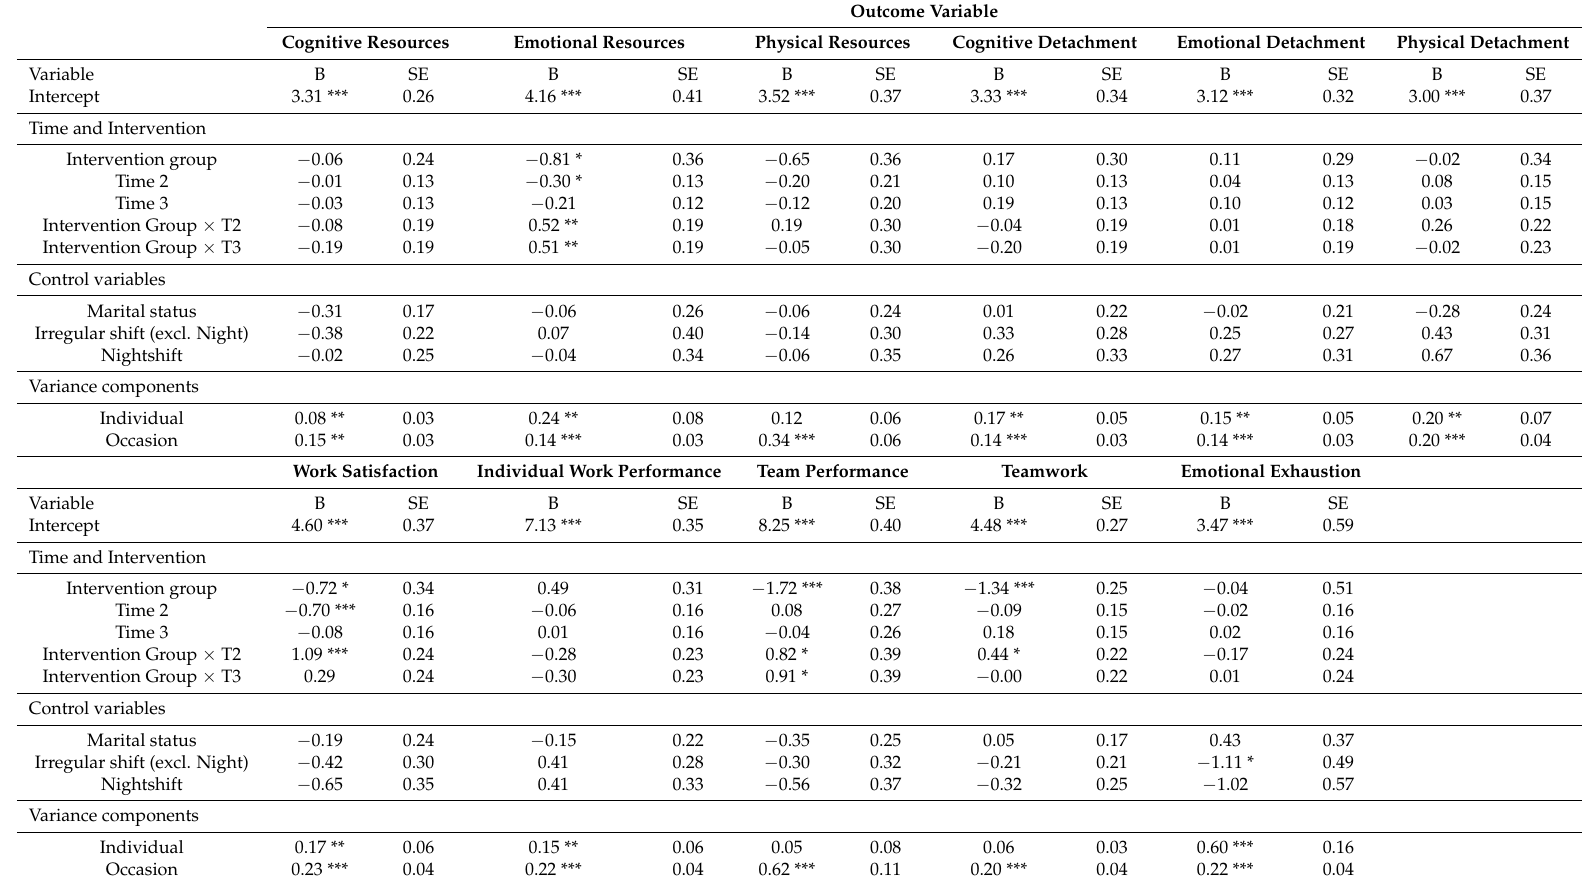
Table A4. Multilevel models for change over time and intervention effects within the laboratory ( N = 35 at Time 1). Outcome